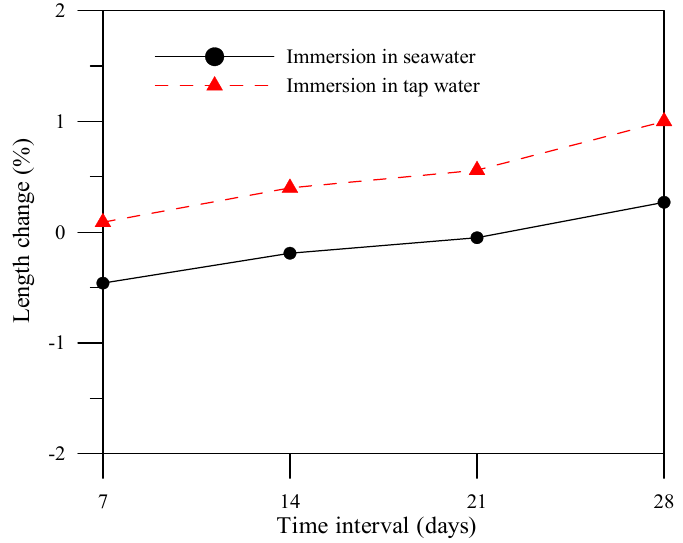
Figure 5. Trend of length change between seawater and tap water (black line: seawater).